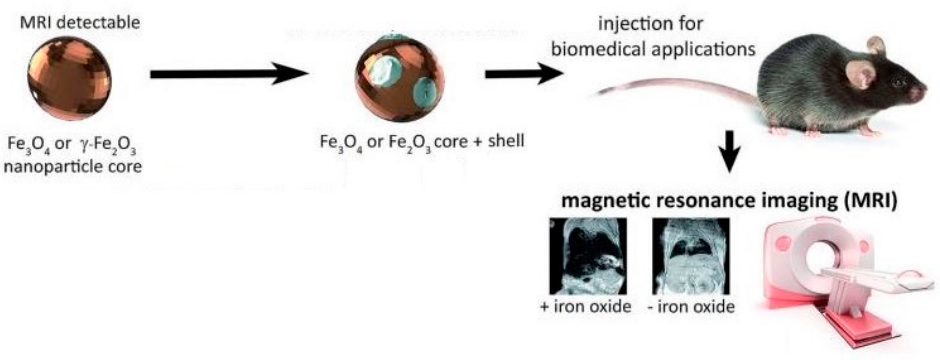
Figure 17. Concept of iron oxide NP application in MR imaging (adopted from [113] with permission from the Royal Society of Chemistry).